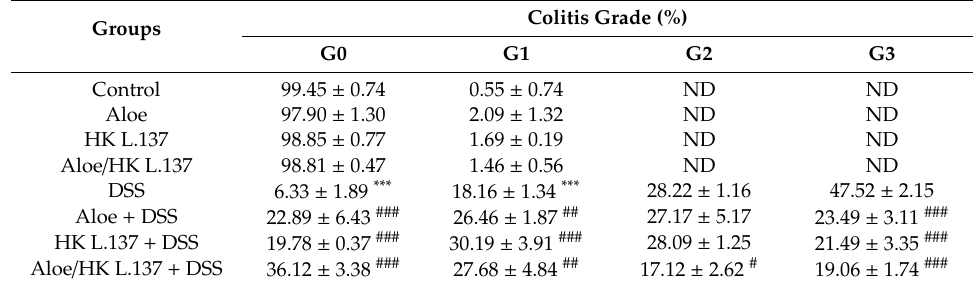
Data are mean ± SD, n = 6. ND = not detected. *** p < 0.001 versus Control, # p < 0.05, ## p < 0.01 and ### p < 0.001 versus